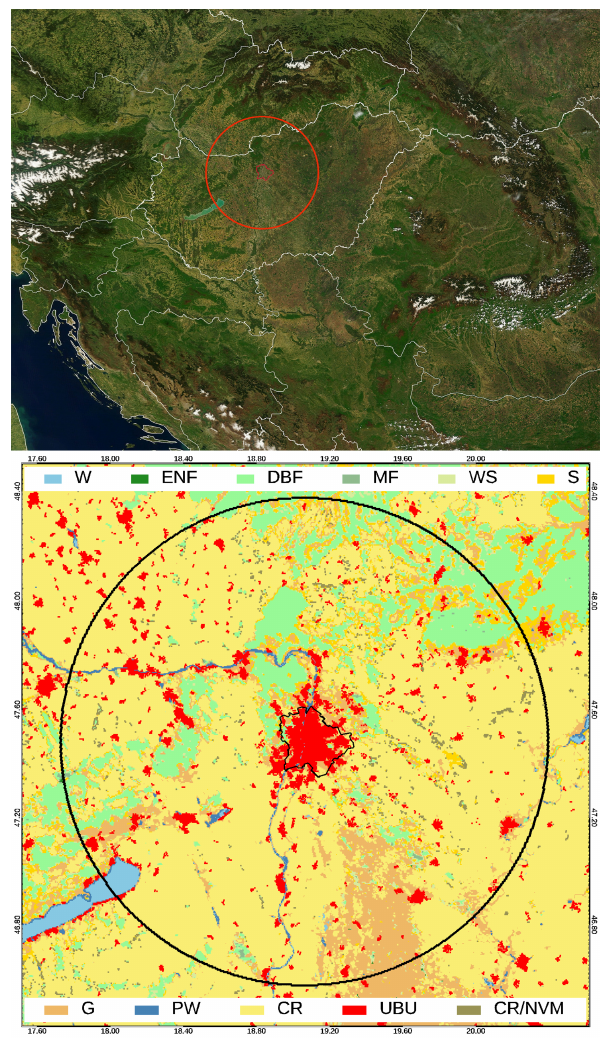
Figure 1. Location of Budapest in the Carpathian Basin and the circular geographical area with a radius of 100km around it, which was considered in modelling calculations (upper panel), and the spatial distribution of land cover types according to the In- ternational Geosphere–Biosphere Programme classification (lower panel). Both pictures were derived from satellite-based imagery data recorded by MODIS. W refers to water bodies, ENF refers to evergreen needleleaf forests, DBF refers to deciduous broadleaf forests, MF refers to mixed forests, WS refers to woody savannas, S refers to savannas, G refers to grasslands, PW refers to permanent wetlands, CR refers to croplands, UBU refers to urban and built- up lands, and CR/NVM refers to cropland and natural vegetation